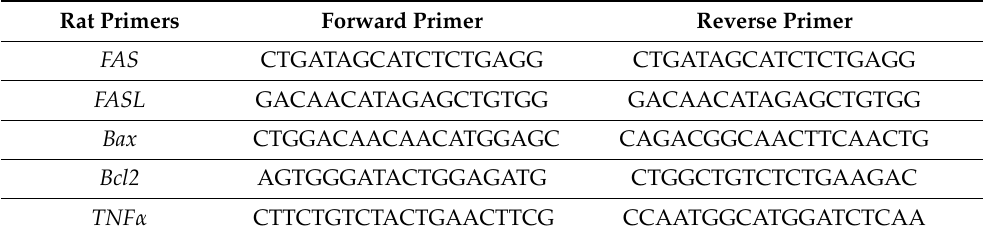
Table 2. Rat primers of all targeted genes used in the quantitative real-time polymerase chain reaction.